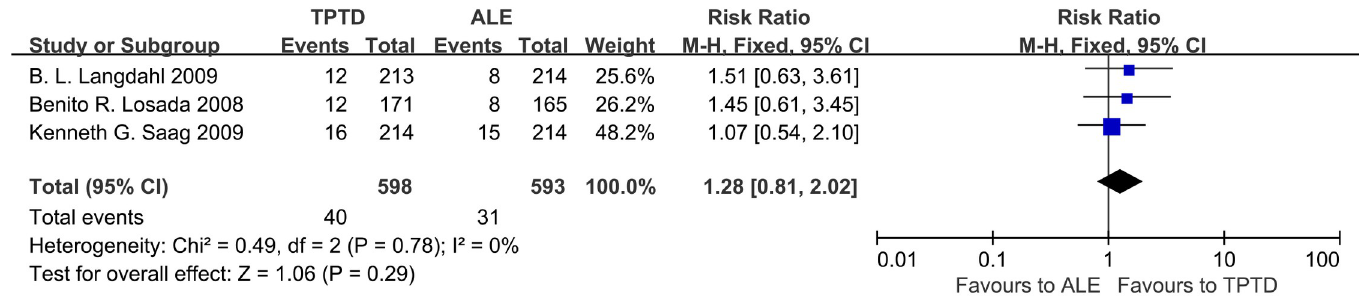
Discussion Through meta-analysis and systematic review of 5 randomized controlled trials, we found that compared with ALE, TPTD can effectively increase the BMD of LS, FN, and TH, and the